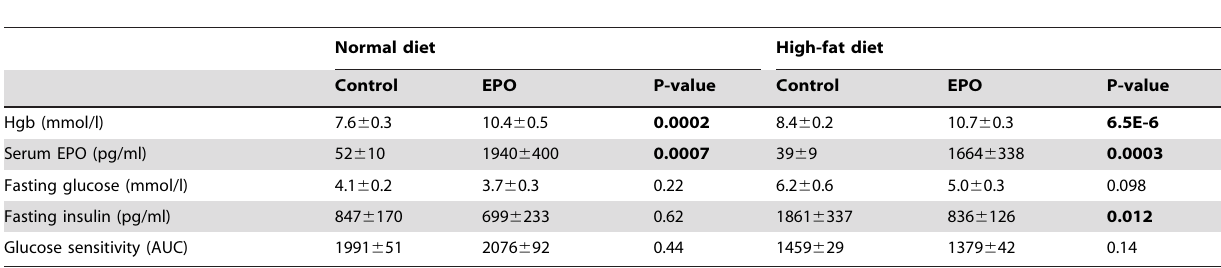
Table 2. Early changes in metabolic parameters one week after EPO electrotransfer.